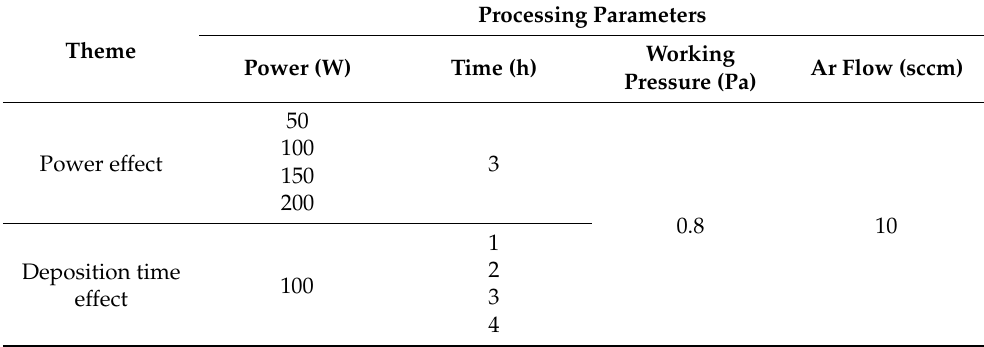
Table 1. The varying processing parameters of TbDyFe thin films deposited on SCD